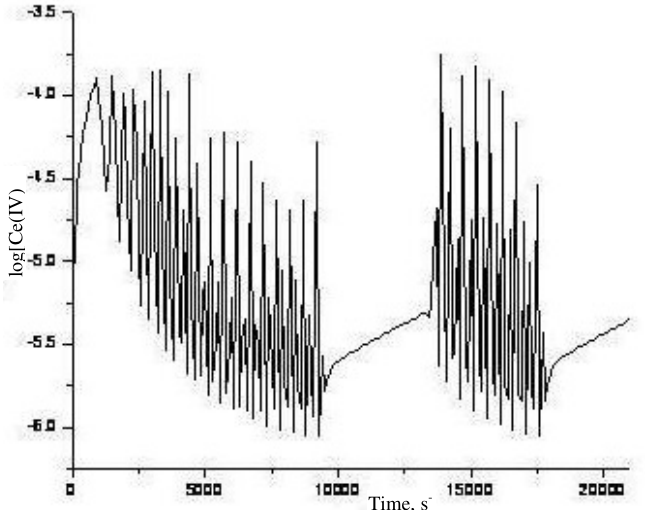
Figure 4 . Bursting oscillations observed in the chaotic model of the BZ reaction with [H - ] = 0.1 M; [H + ] =0.26 M; [MA] =0.02 M; [Ce(IIII)] = 0.004 M at a flow rate =55 M, [BrO 3 of 3.071x10 -4 s -1